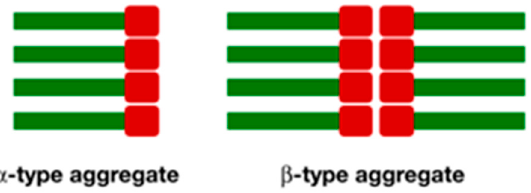
Figure 4. Cartoon representing the spatial disposition of monomers in α - and β -aggregates.